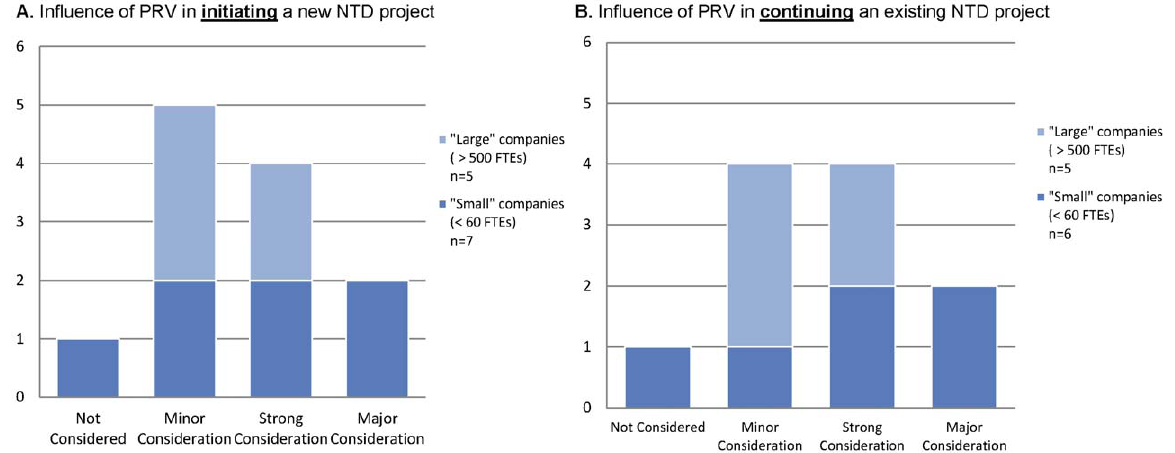
Figure 1. Industry response to priority review voucher (PRV) influence on decision making. Companies rated the importance of the PRV on initiating (A) and continuing (B) R&D projects for new neglected tropical disease (NTD) medicines. Responses were identified into ‘‘large’’ companies ( . 500 FTEs) and ‘‘small’’ companies ( , 60 FTEs). Note: One small company did not respond to the survey question that supplied the data for